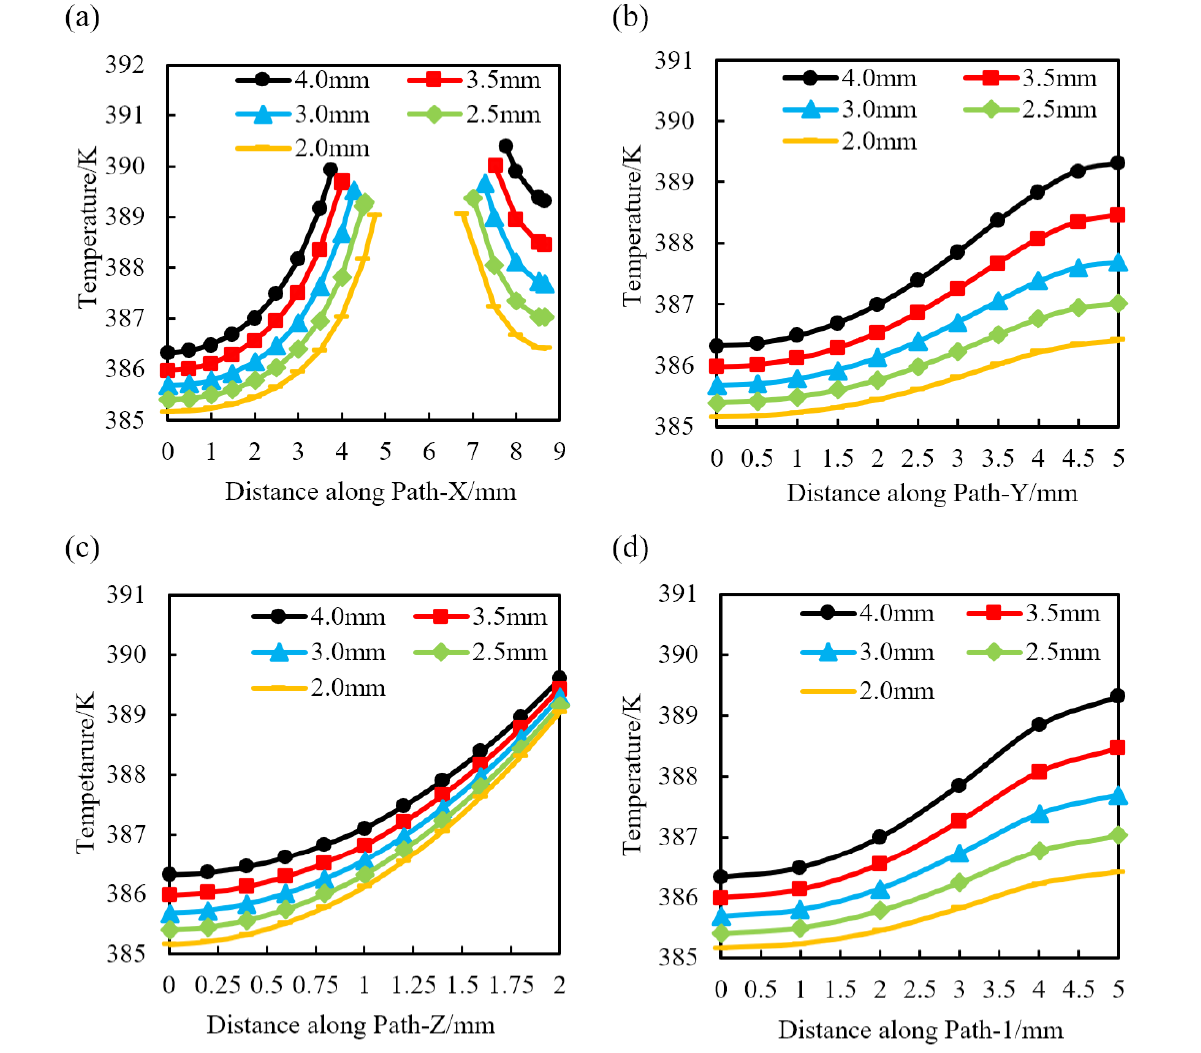
Figure 14. Temperature distribution of triaxial geogrid with a different pre-punched diameter along each path. ( a ) Path-X, (b) Path-Y, ( c ) Path-Z, ( d )